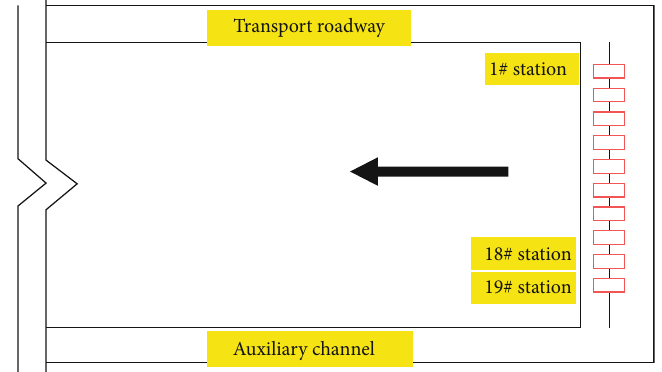
Figure 15: Working face pressure monitoring system layout. Table 4: Related data of working resistance of hydraulic supports (in the upper part of working